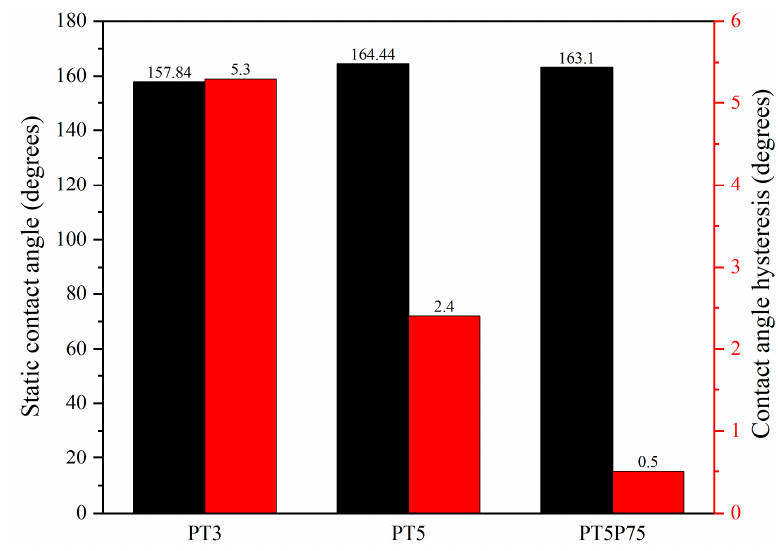
Figure 16. Static and dynamic contact angle for PT3, PT5, and PT5P75.